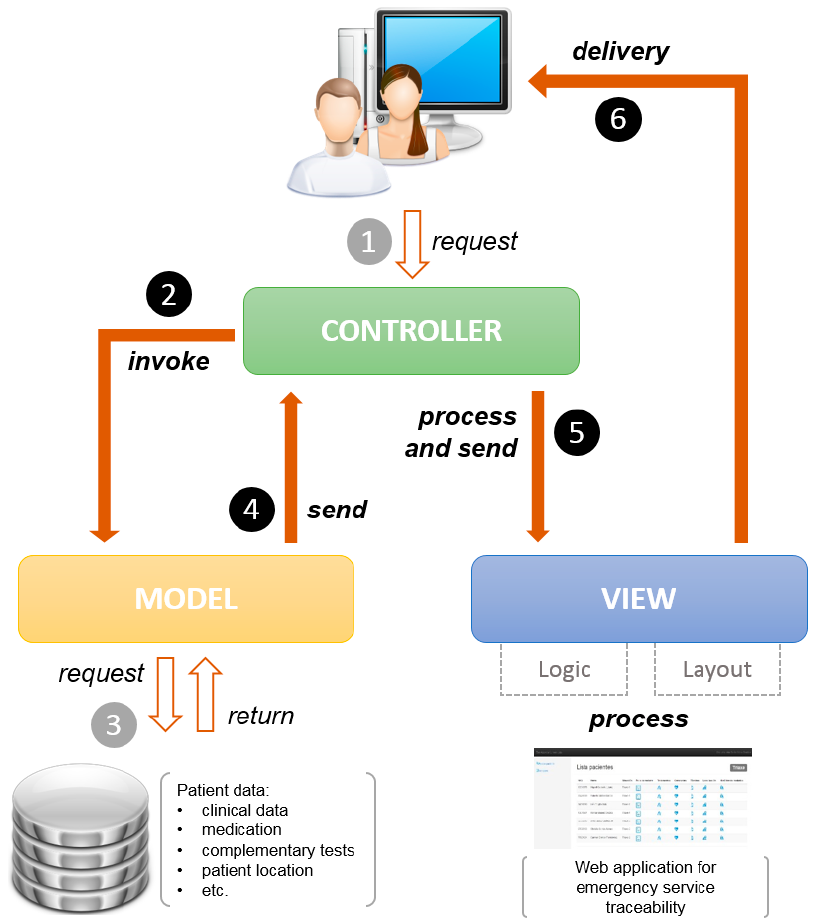
Figure 2. Model–view–controller pattern in the developed application.